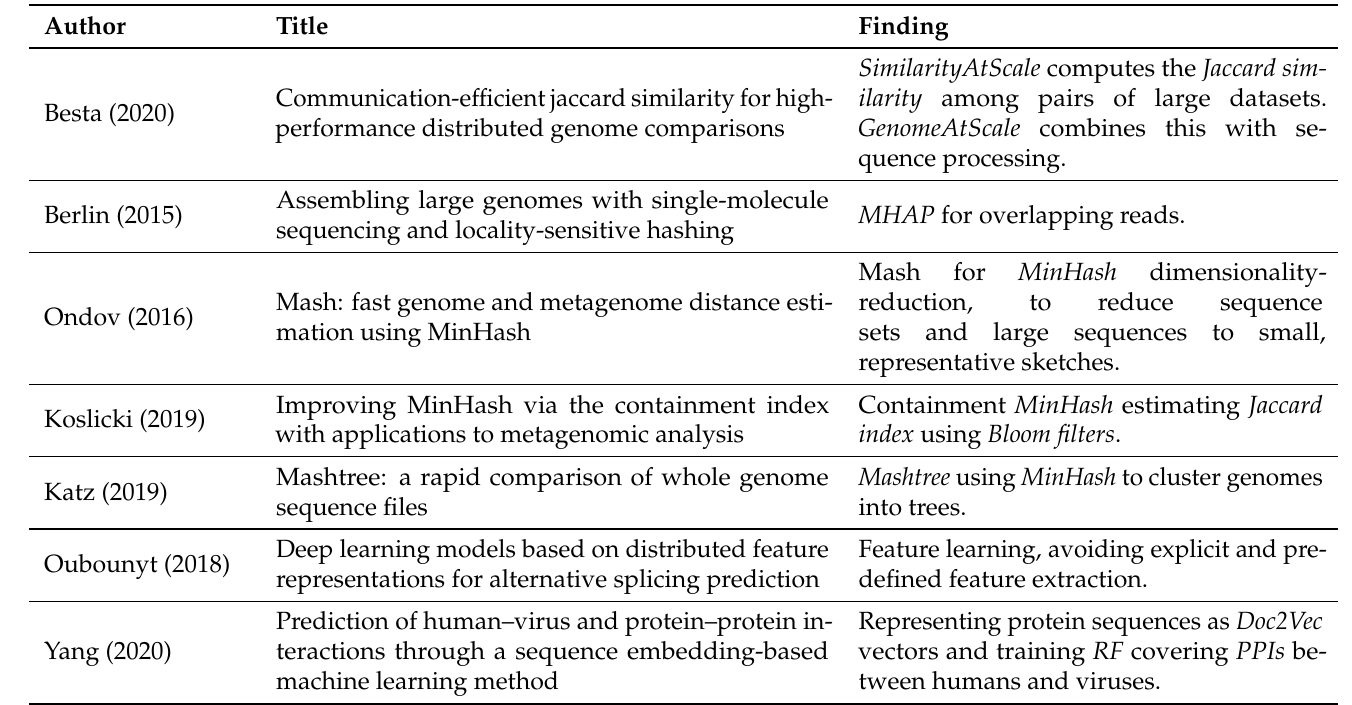
Table 1. Literature summary